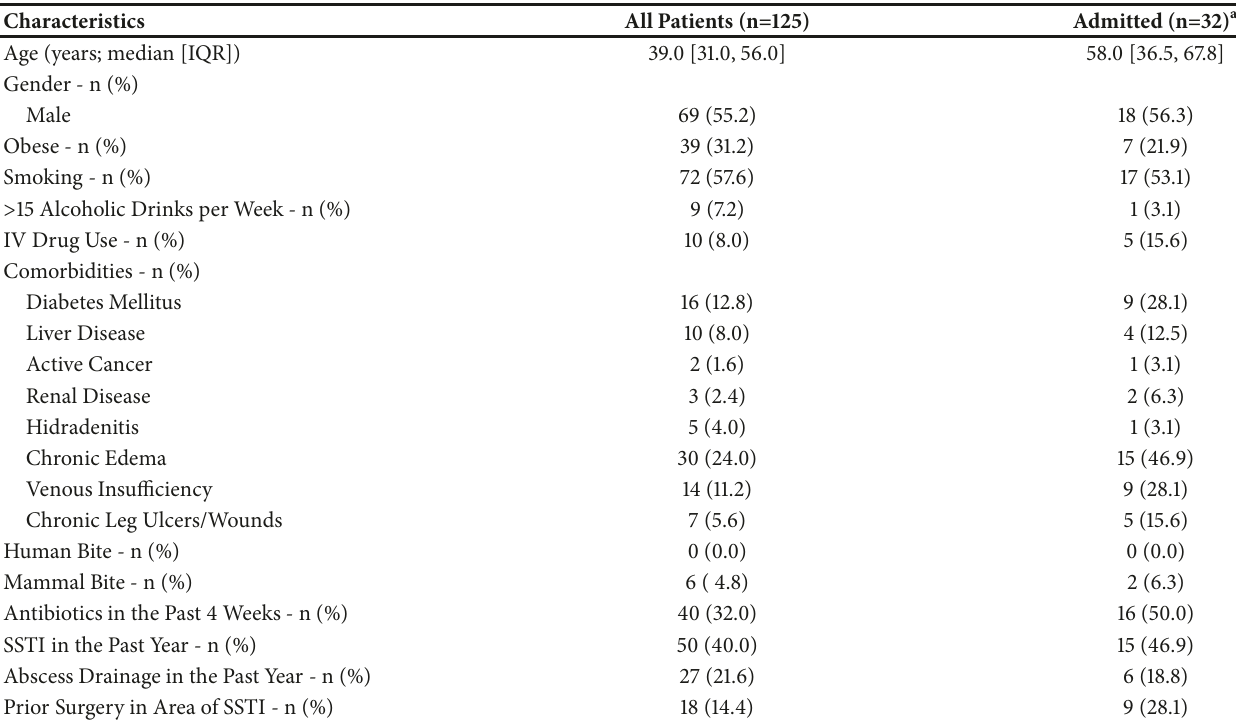
Table 1: Demographic data and characteristics of enrolled